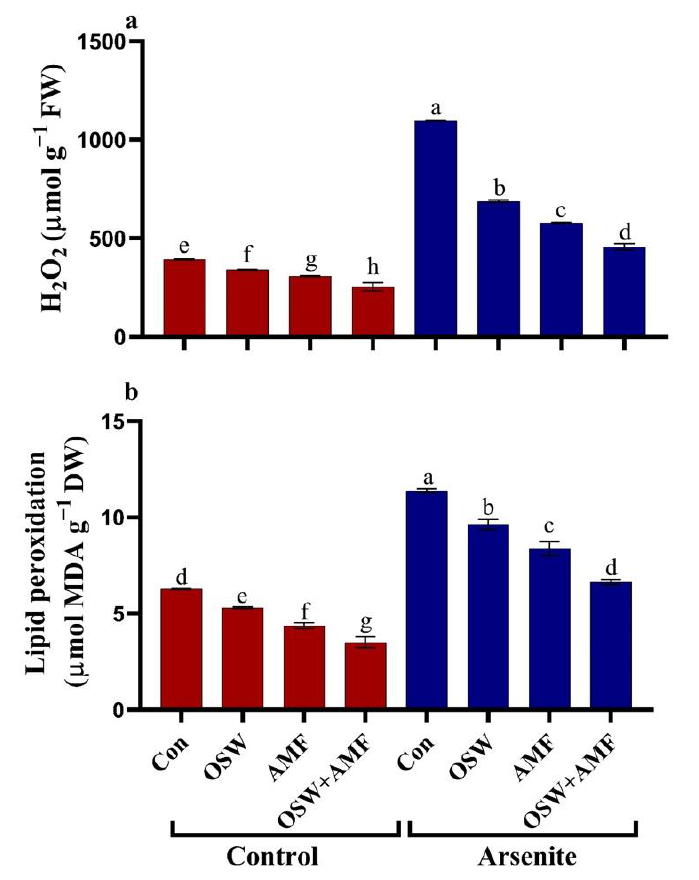
Figure 3. The influence of olive solid waste (OSW) and arbuscular mycorrhizal fungi (AMF), com- bination (OSW + AMF) on H 2 O 2 and MDA in wheat plants growing under As stress. H 2 O 2 level ( a ) and lipid peroxidation (MDA) ( b ). Fishers test at p < 0.05 reveals significant variations in means (± standard deviation), which are different letters on the same bars.